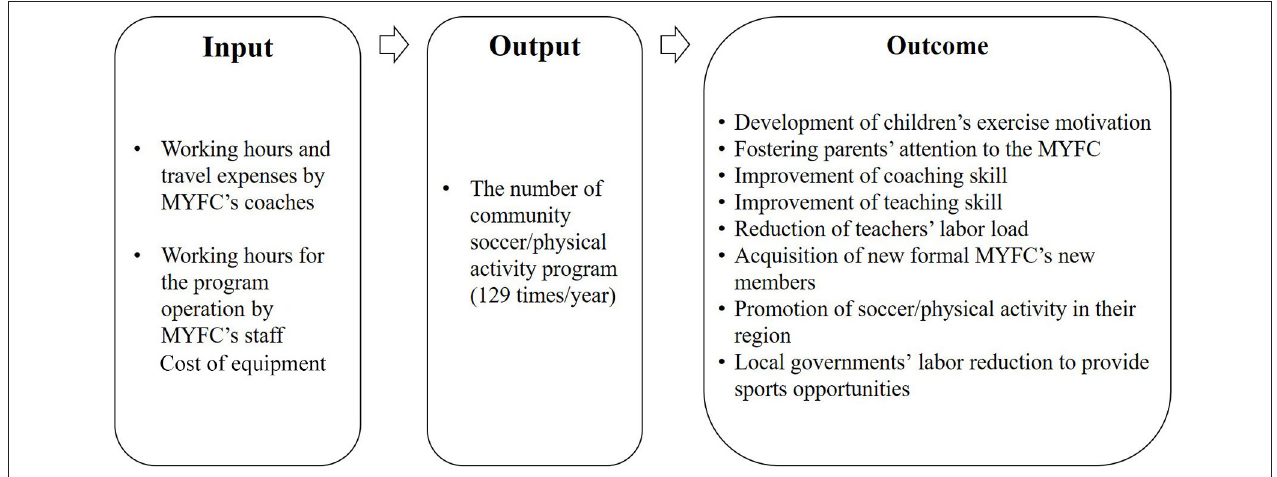
FIGURE 3 | Overview of the impact